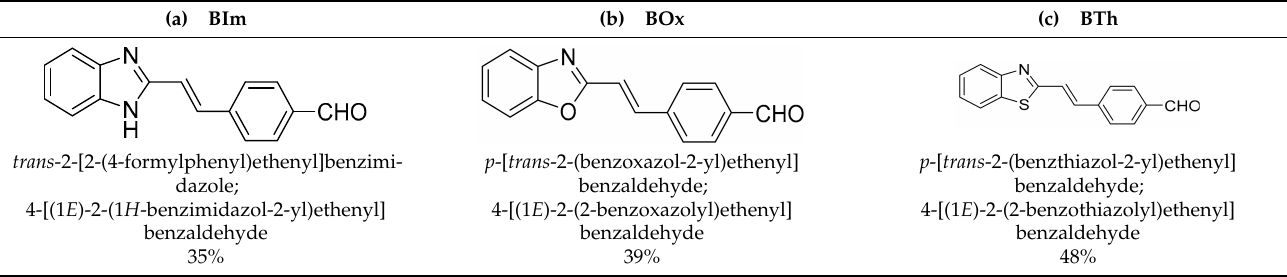
Table 1. The abbreviations, chemical structures, two alternative names, and reaction yields of obtained dyes. (a) BIm (b) BOx (c) BTh